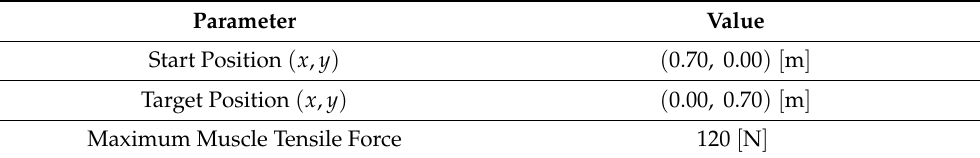
Table 5. Parameter settings of simulation